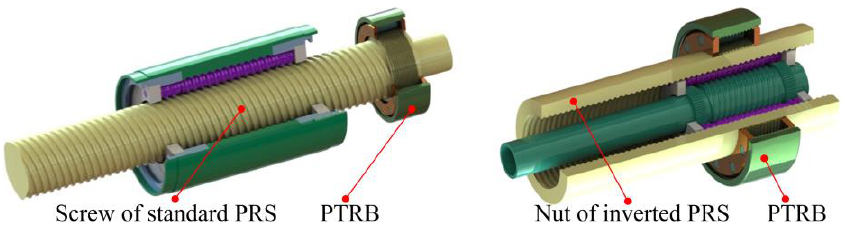
Figure 1. Integration scheme of PTRB and PRS.